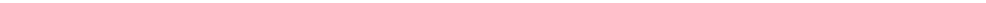
(see fi gure on previous page) Fig. 4 Overexpression of Ndufs6 in Ndufs6 − / − -BM-MSCs decreases cellular senescence. A The mRNA level of Ndufs6, p53, and p21 was detected by RT-PCR in Ndufs6 − / − -BM-MSCs and Ndufs6-AAV2-treated Ndufs6 − / − -BM-MSCs. B The protein level of Ndufs6, p53, and p21 was detected by western blotting in Ndufs6 − / − -BM-MSCs and Ndufs6-AAV-treated Ndufs6 − / − BM-MSCs. C SA- β -gal staining showing β -gal-positive cells in Ndufs6 − / − -BM-MSCs and Ndufs6-AAV-treated Ndufs6 − / − BM-MSCs. D The β -gal positivity in Ndufs6 − / − -BM-MSCs and Ndufs6-AAV-treated Ndufs6 − / − BM-MSCs was quanti fi ed by calculating the ratio of stained cells to total cells. E The proliferation of Ndufs6 − / − -BM-MSCs and Ndufs6-AAV-treated Ndufs6 − / − BM- MSCs was assessed by Ki-67 staining. F The Ki-67 positivity in Ndufs6 − / − -BM-MSCs and Ndufs6-AAV-treated Ndufs6 − / − BM-MSCs was quanti fi ed by calculating the ratio of stained cells to total cells. Results are presented as mean± SD. n = 3. **p < 0.01; ***p